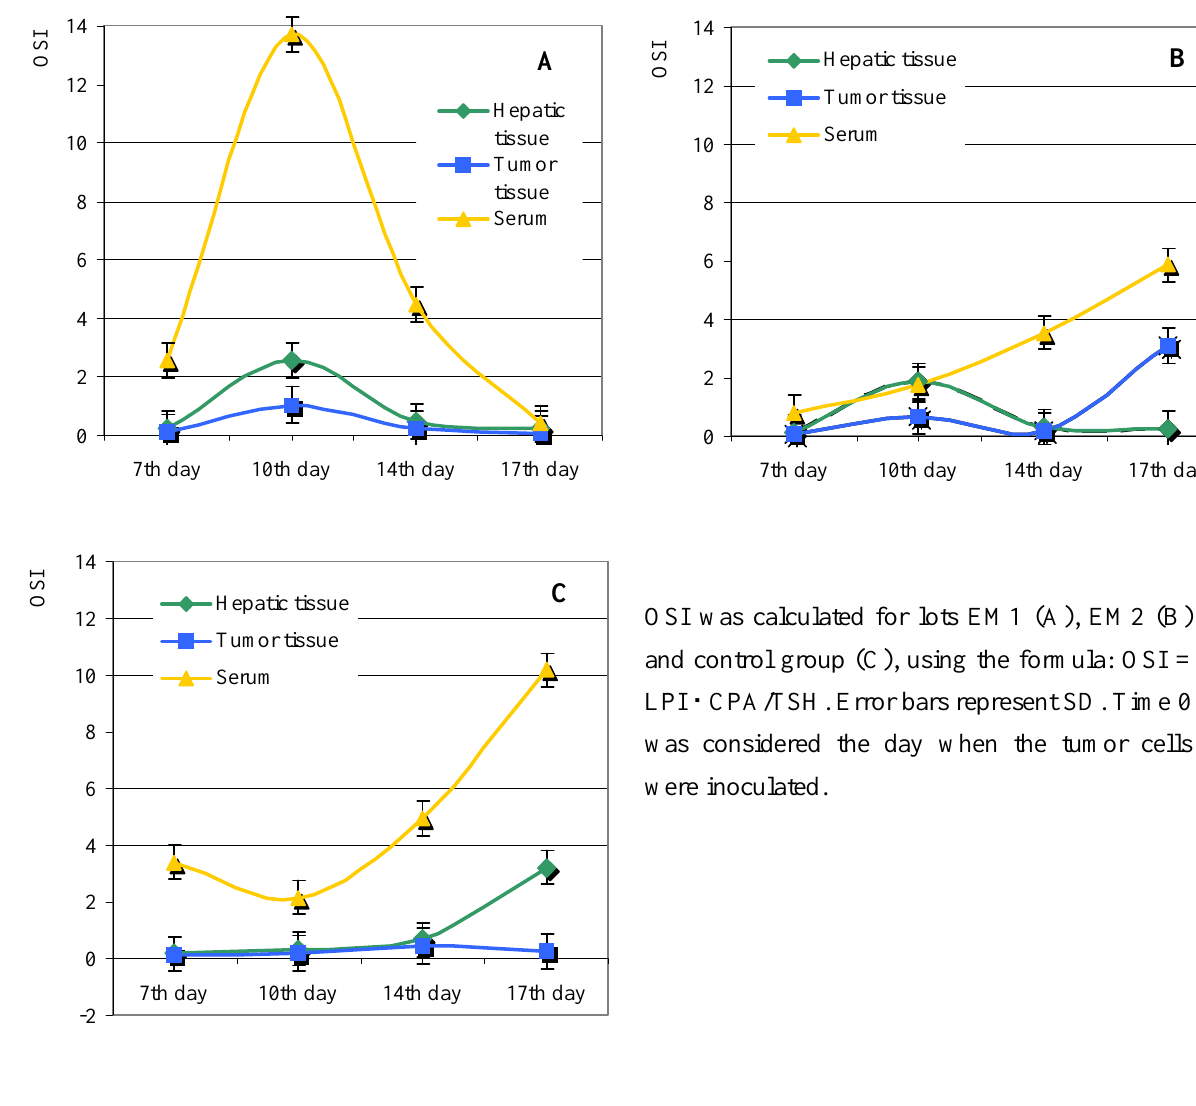
Figure 5 . Effect of Lonicera caerulaea berry extracts on the oxidative stress index (OSI).